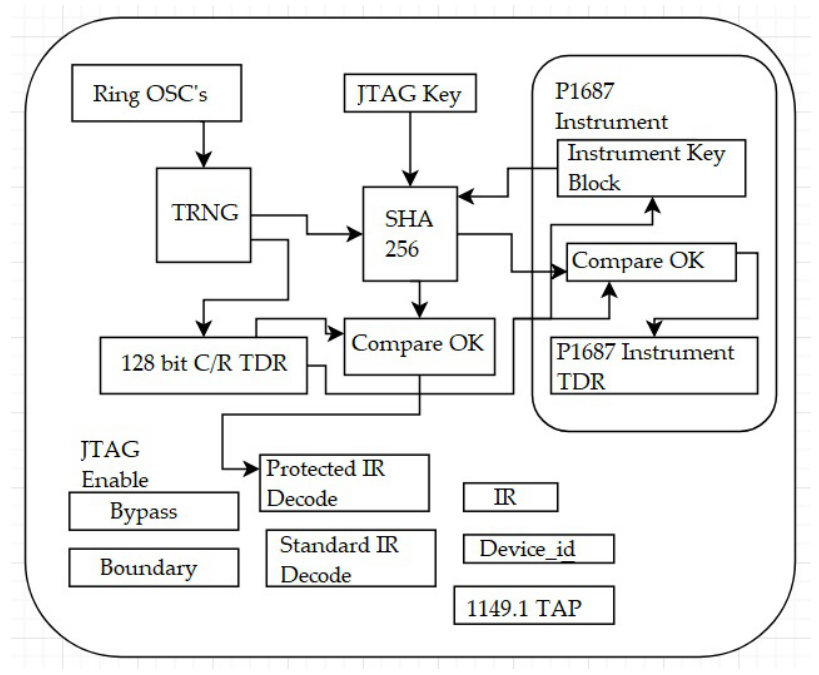
Figure 3. IC with anti-tamper JTAG